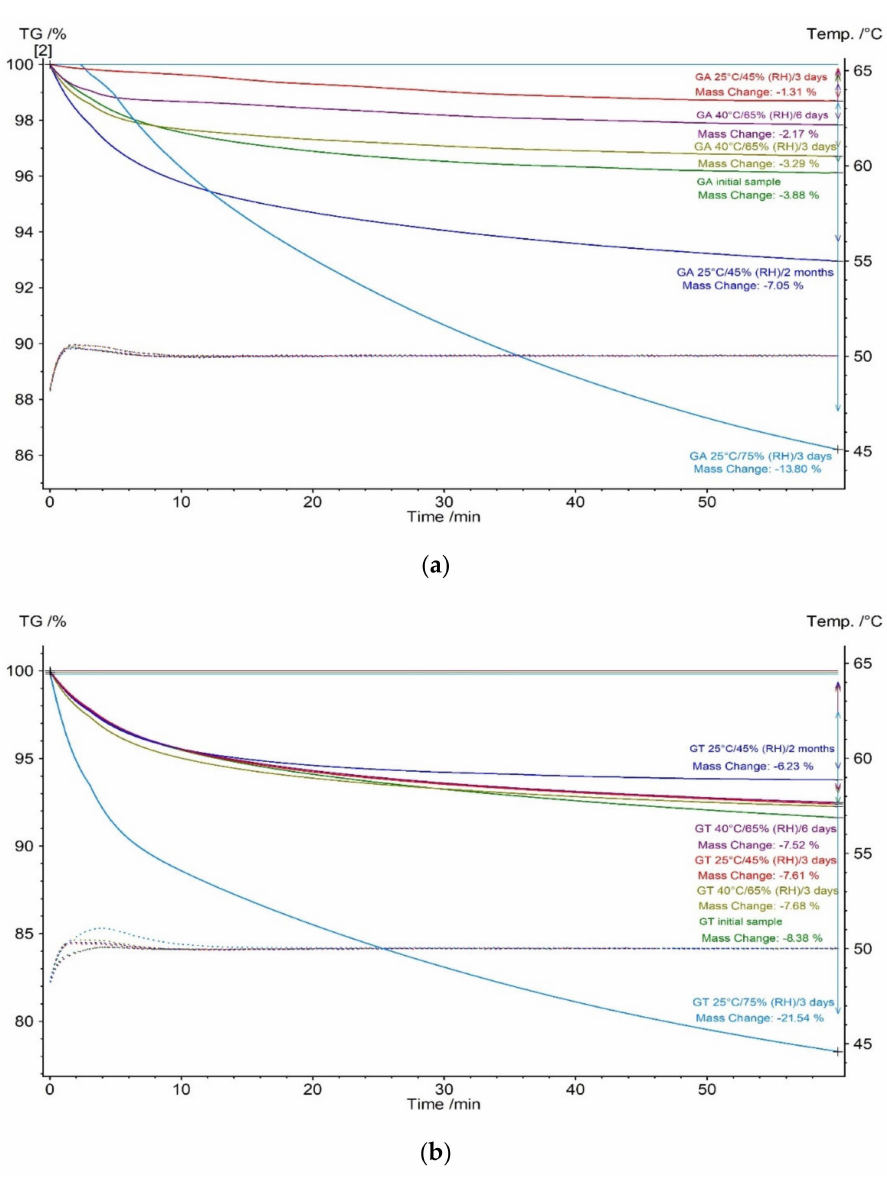
Figure 4. TG isothermal curves of ( a ) gum arabic and ( b ) gum tragacanth storage in different conditions (temperature/RH/time). Measurements were performed at 50 ◦ C for 60